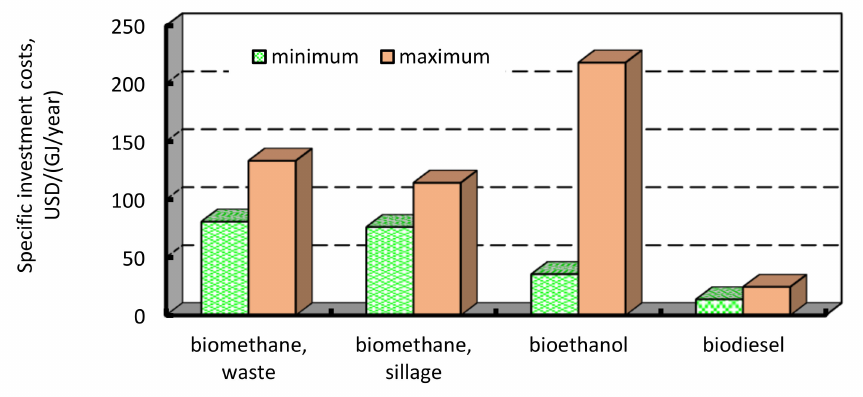
Figure 9. Specific investment costs.